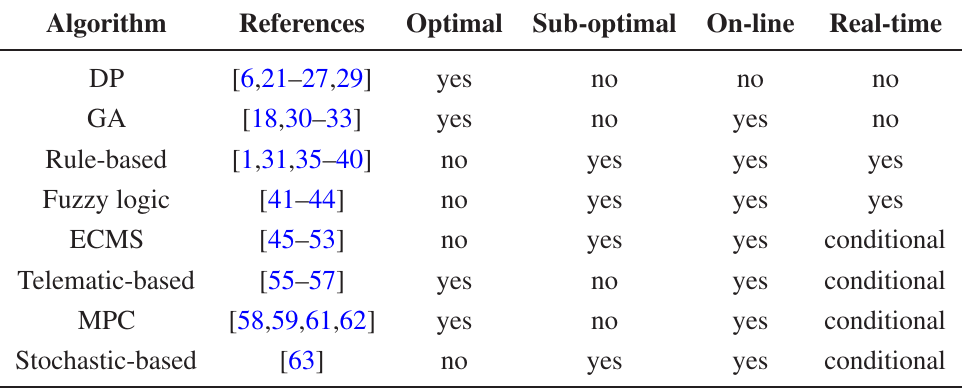
Table 2. Comparison of different power management algorithms.